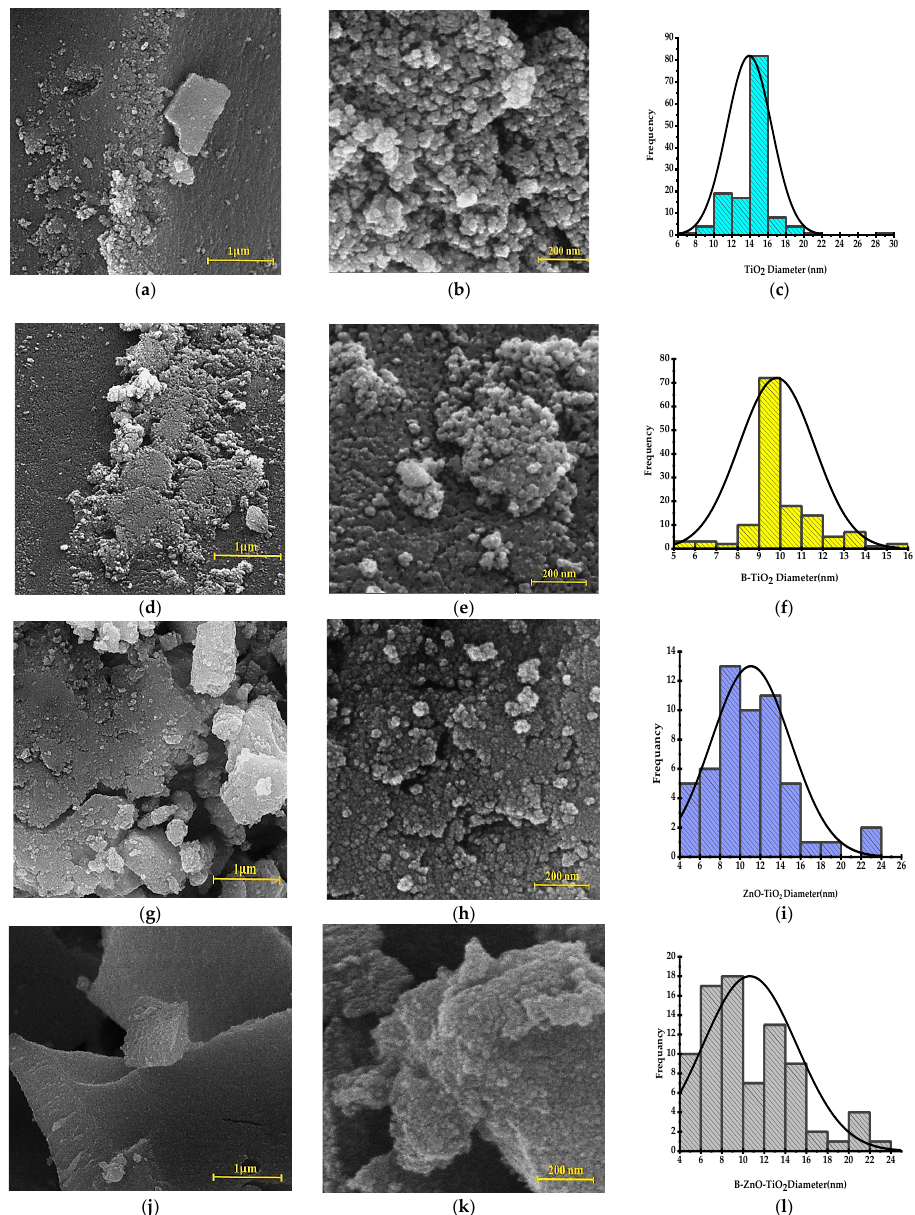
Figure 2. XRD patterns of TiO 2 , B-TiO 2 , ZnO/TiO 2 , and B-ZnO/TiO 2 . The SEM images of pure TiO 2 , B-TiO 2 , ZnO-TiO 2 , and B-ZnO/TiO 2 are presented in Figure 3. The SEM images of pure TiO 2 , B-TiO 2 , and ZnO/TiO 2 illustrate the catalyst outer surfaces are grainy, spherical, and aggregated, with a wide range of particle sizes. The particle size decreased following the addition of B and ZnO into TiO 2 . The particles of the B-ZnO/TiO 2 composite had an incomplete spherical shape and were highly agglomerated, due to their small size and the amorphous nature of the photocatalytic composite (Figure 3j – l). In the SEM images, the particle size was calculated using the NIH Image J software. The crystallite and particle size of pure TiO 2 , B-TiO 2 , ZnO/TiO 2 , and B-ZnO/TiO 2 are summarized in Table 2. Furthermore, the distribution and uniform features for element mapping are investigated by EDS spectra in Figure 4. The EDS elemental mapping of B-doped ZnO/TiO 2 clearly confirms the presence and uniform spatial distribution of Ti, O, Zn, and B in the nanocomposite (Figure 4a – d).